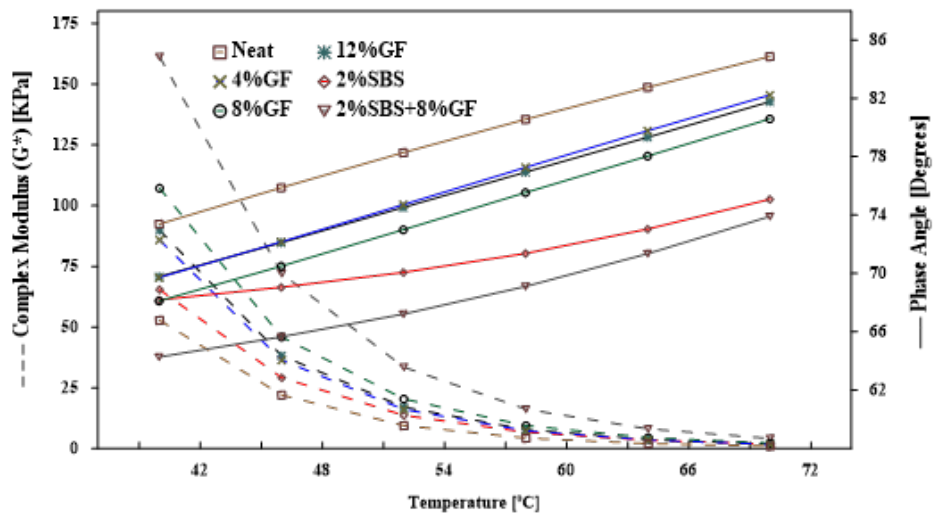
Figure 3. Temperature effect on the complex shear modulus and phase angle at 10